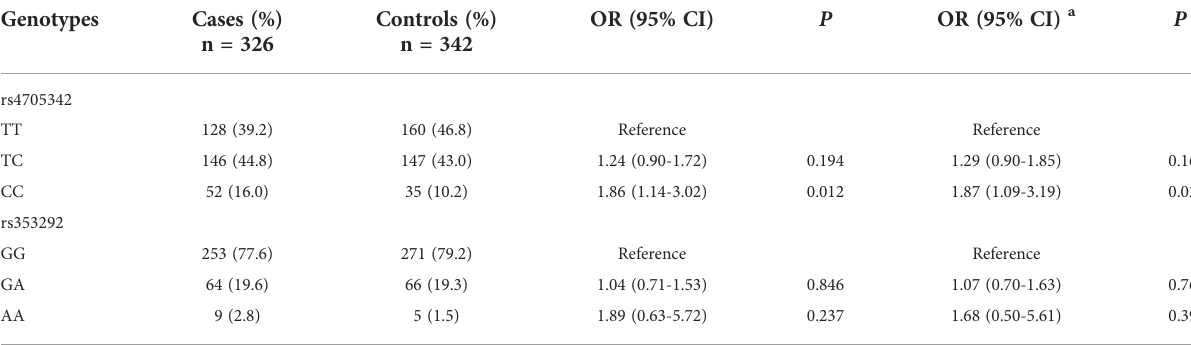
TABLE 2 Association between the two polymorphisms of miR-143 and the risk of